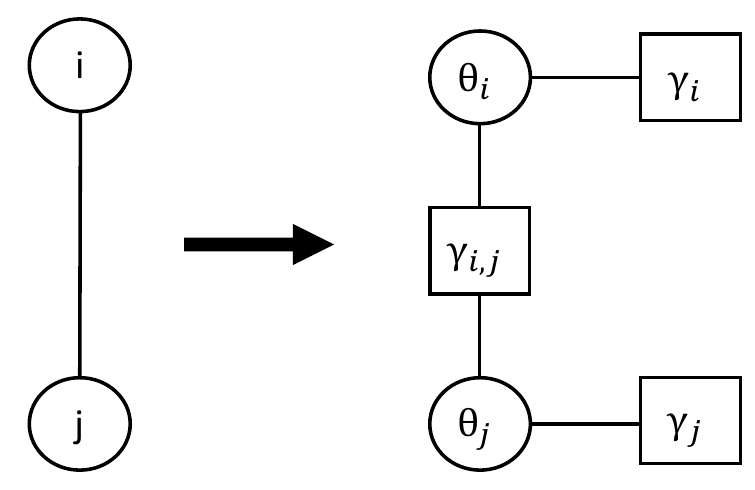
Figure 5. The factor graph of nodes i and j